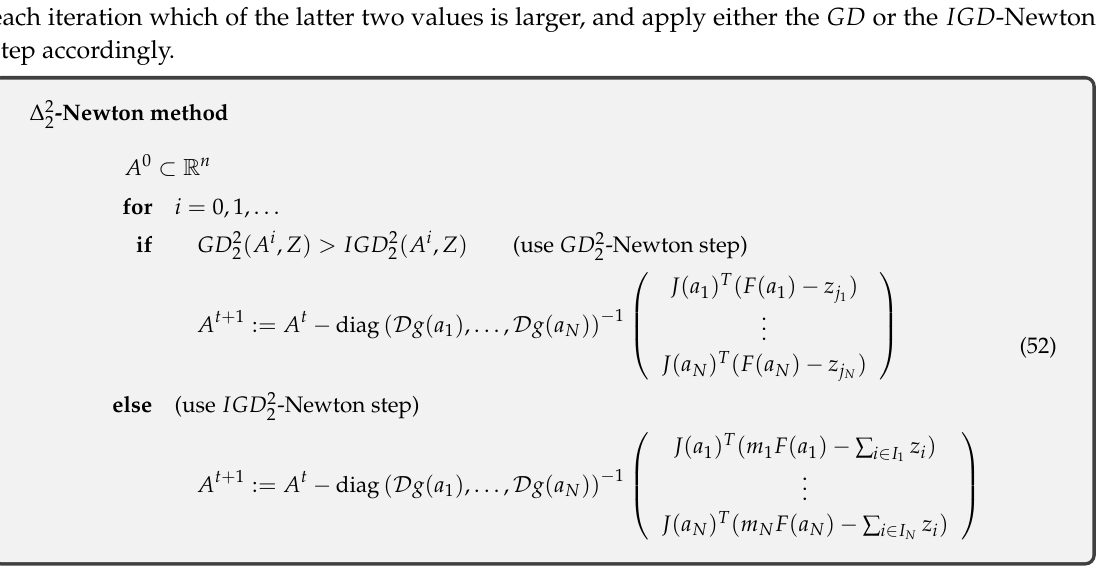
-Newton method on BOP (51). ( Right ) only the final archive is 2